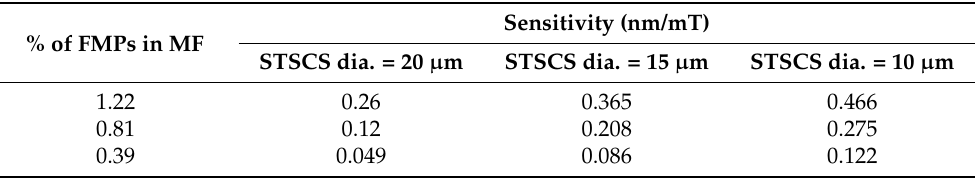
Table 1. Sensitivity values for the STSCS optical fibre sensor of 10, 15, and 20 µ m diameter surrounded by 0.39, 0.81, and 1.22% FMPs in the MF.